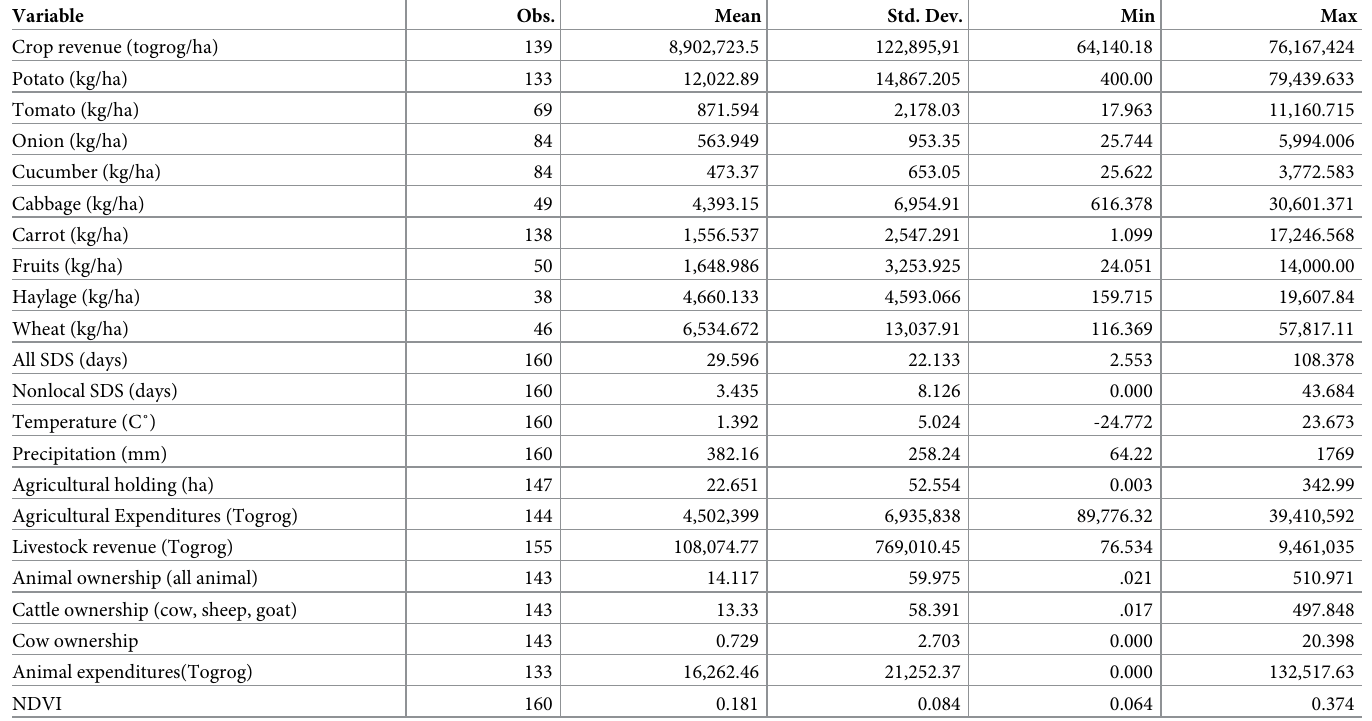
Table 2. Descriptive statistics of the variables used in the